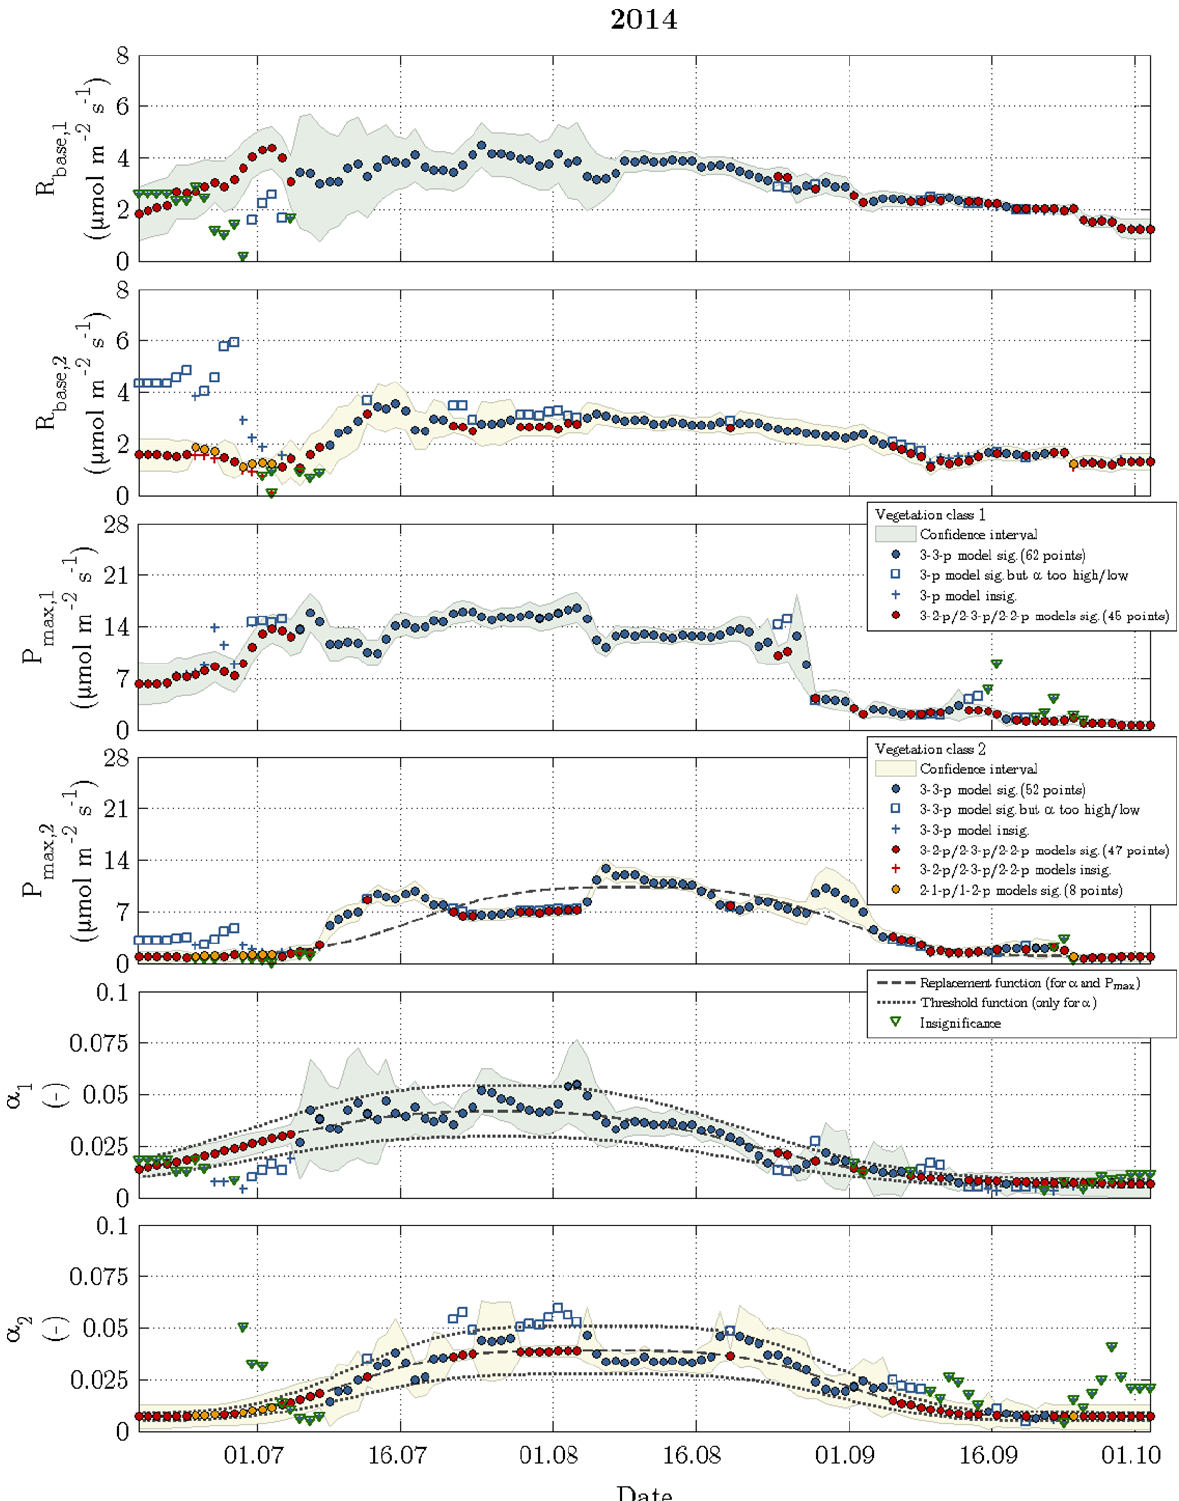
Figure 6. Time series of fitting parameters in 2014 for vegetation class 1 (index 1 and green confidence intervals) and vegetation class 2 (index 2 and yellow confidence intervals). The circles represent acceptable fits, while the respective reasons for reparameterisation such as insignificant values or values out of valid range are indicated by plus signs and squares. The triangles denote the fitting parameter(s), which caused a refit in the corresponding vegetation